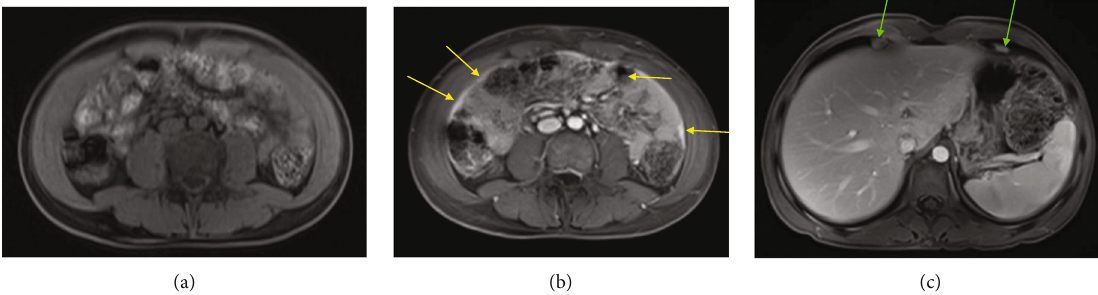
Figure 9: MRI of the abdomen and pelvis three months after the patient ’ s initial MR left T1 precontrast (a), middle T1 postcontrast (b), and right T1 postcontrast (c) showed persistent but decreased peritoneal thickening/enhancement. Pulmonary nodules are decreased in size. No signi fi cant ascites is